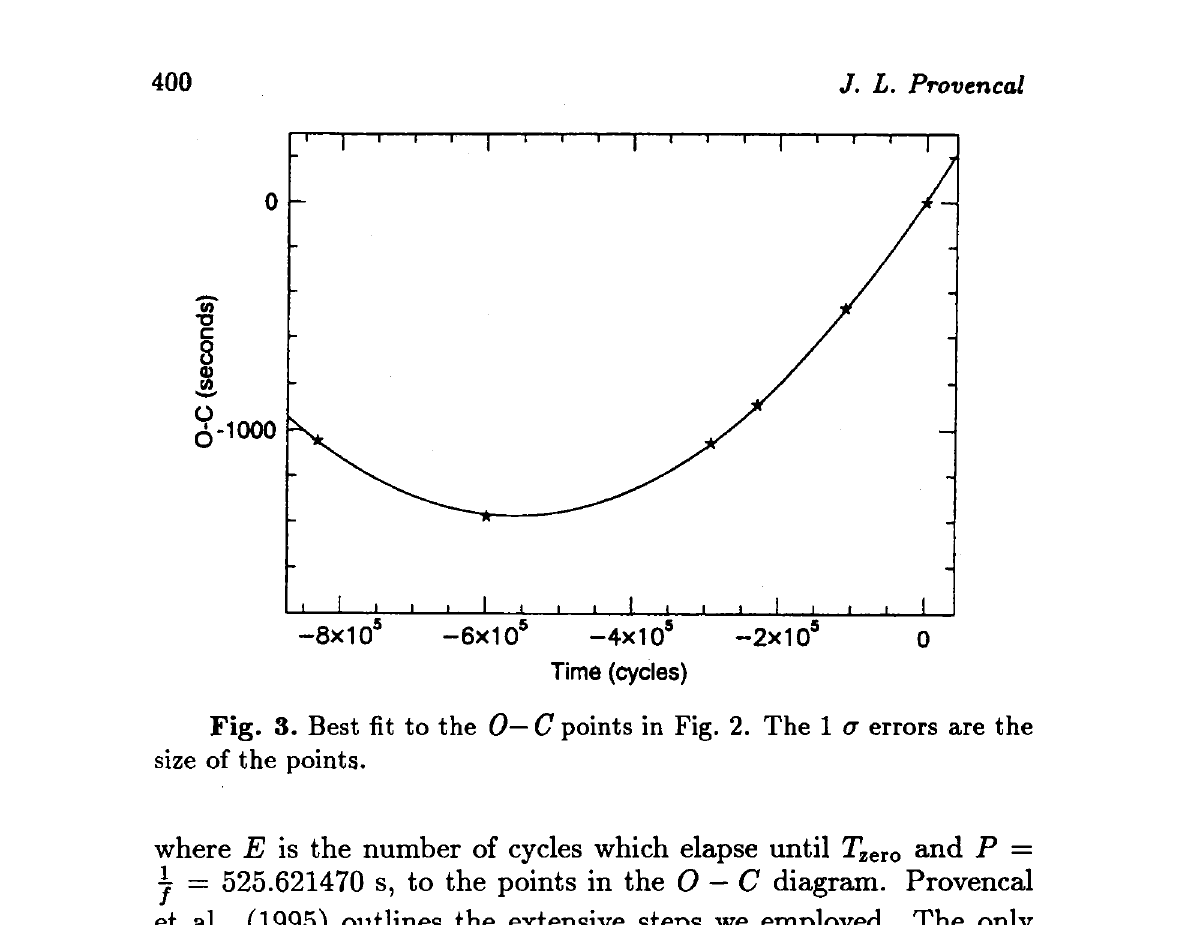
Fig. 3. Best fit to the 0— C points in Fig. 2. The 1 a errors are the size of the